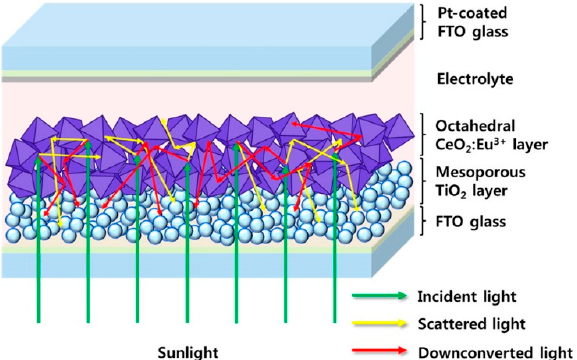
Figure 19. Schematic of a bilayer dye-sensitised solar cell device fabricated from hydrothermally synthesised octahedral CeO 2 :Eu 3+ nanocrystals for light scattering and down conversion [116]. Reprinted with permission from Roh, J.; Hwang, S.H.; Jang, J. Dual-Functional CeO 2 :Eu 3+ Nanocrystals for Performance-Enhanced Dye-Sensitized Solar Cells. ACS Appl. Mater. Interfaces 2014 , 6 , 19825–19832. Copyright (2014) American Chemical Society.